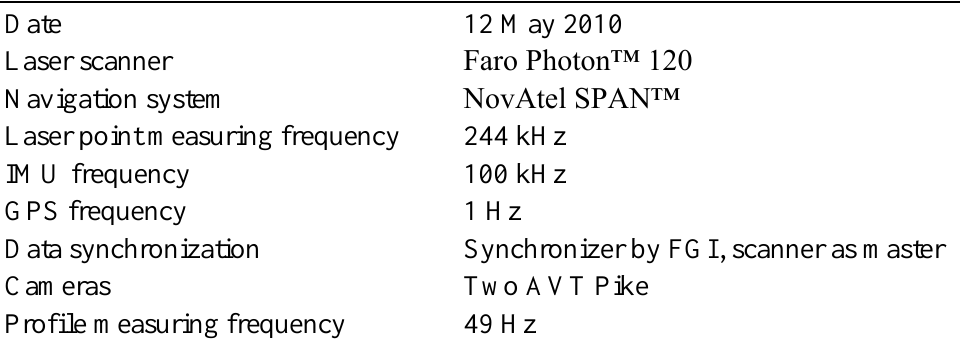
Table 1. The ROAMER‘s acquisition